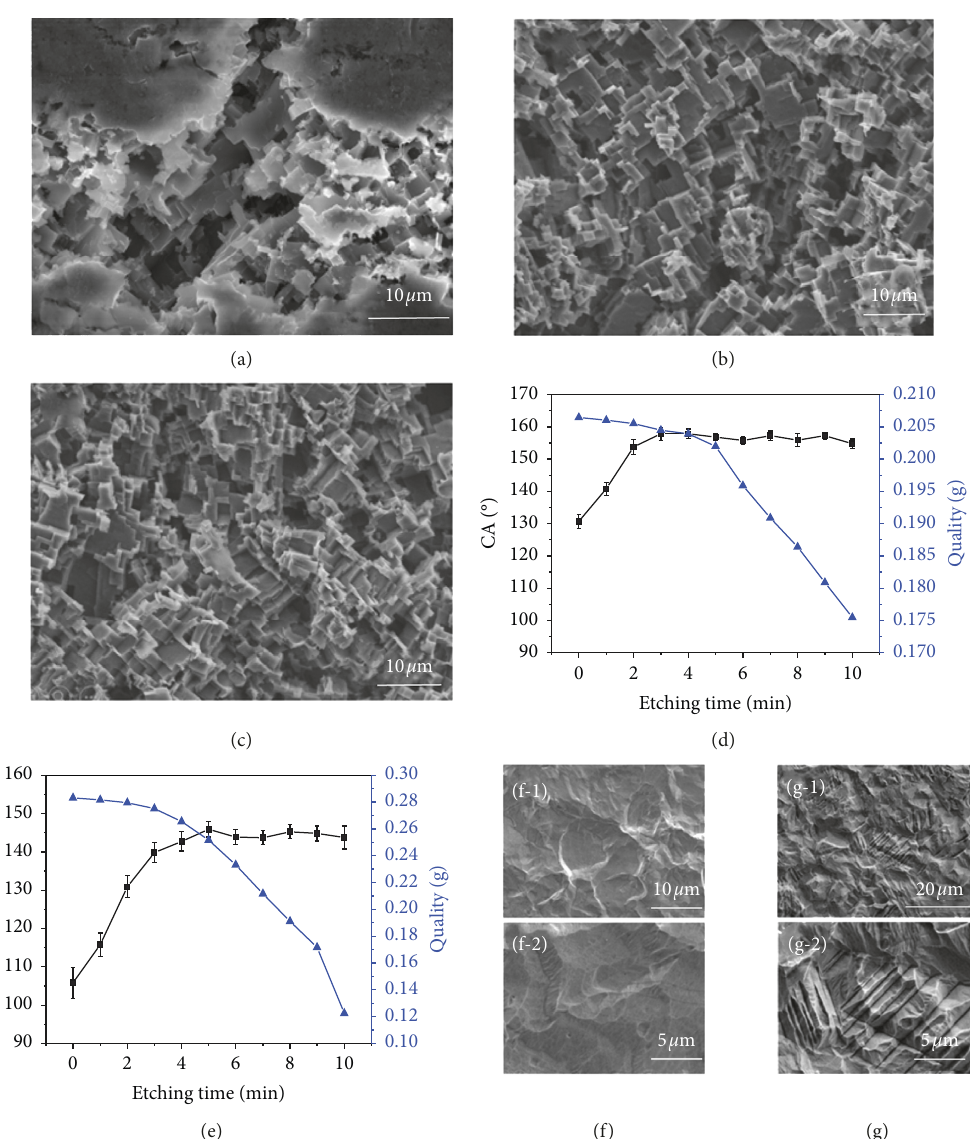
Figure 7: FESEM of Al alloy surface after (a) 1min, (b) 3 min, (c) 10min etching time and stainless steel surface after (f) 1min and (g) 10min etching time. The changes of the brine contact angle and weight of (d) Al alloy sample and (e) stainless steel sample with etching time.